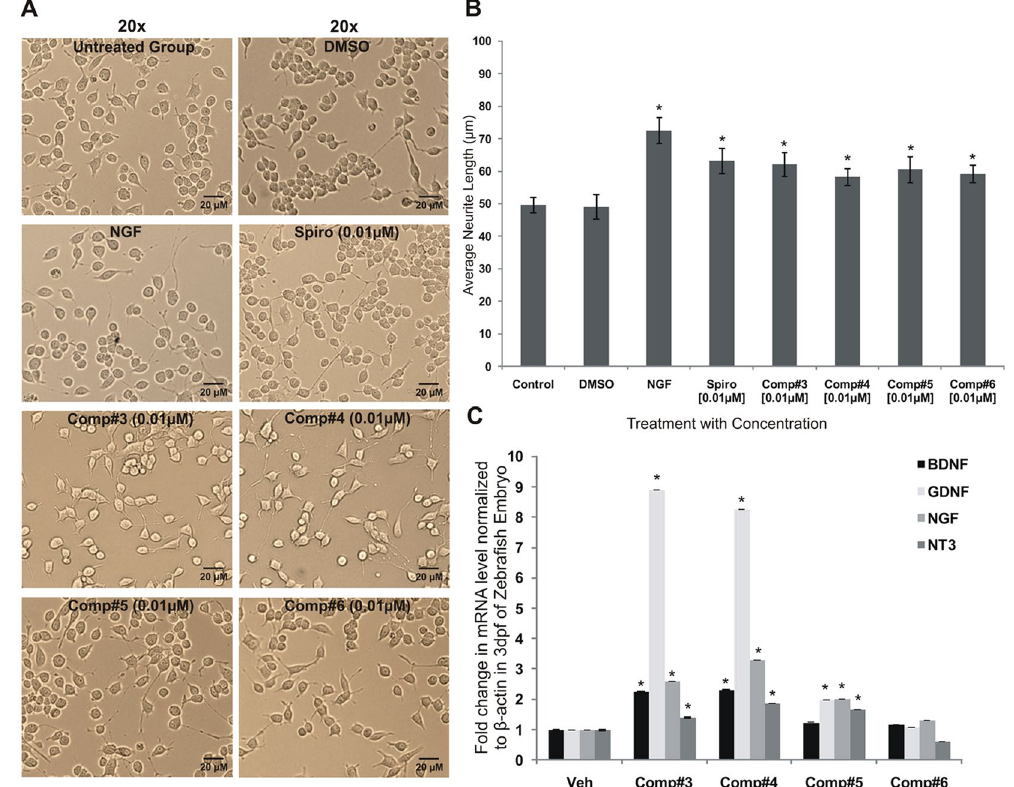
Figure 2. ( A ) Showing the morphometric analysis of neurite outgrowth of differentiated Neuro2A cells cultured for 24 h, followed by the treatment with NGF [200 ng/mL], DMSO [1%] and compounds #3–# 6 [0.01 μ M]. ( B ) The tabulated and bar graph data are expressed as mean ± SEM where n = 60 and compared with the control. Note that all of them showed remarkable neurotrophic activity as compared to the untreated and DMSO-treated controls, * p < 0.05. ( C ) The relative level of expression in genes that code for neurotrophic factors like BDNF, GDNF, NGF and NT3 in 3dpf of Zebrafish larvae. Values are means + SEM, (n = 3), and each group containing 60 larvae, * p <